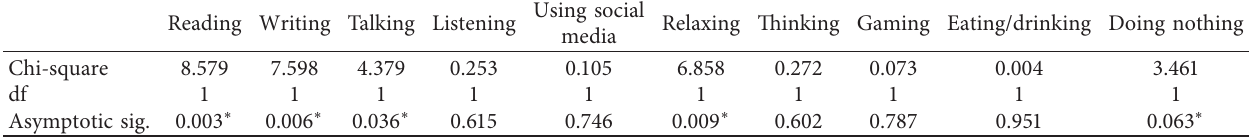
Table 11: Kruskal–Wallis test statistics of the gender groups.